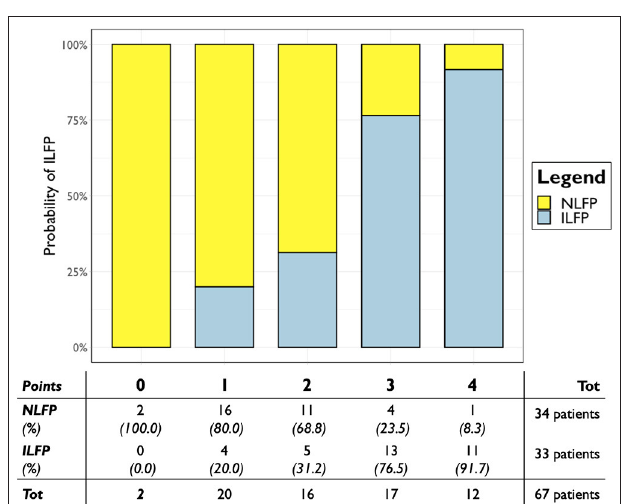
FIGURE 3 | Predicted probability of PCWP > 15 mmHg according to the developed scoring system in the whole population. Scoring points are represented on the x-axis; probability of ILFP is represented on the y-axis. ILFP, increased left ventricular filling pressure; NLFP, normal left ventricular filling pressure; PCWP, postcapillary wedge